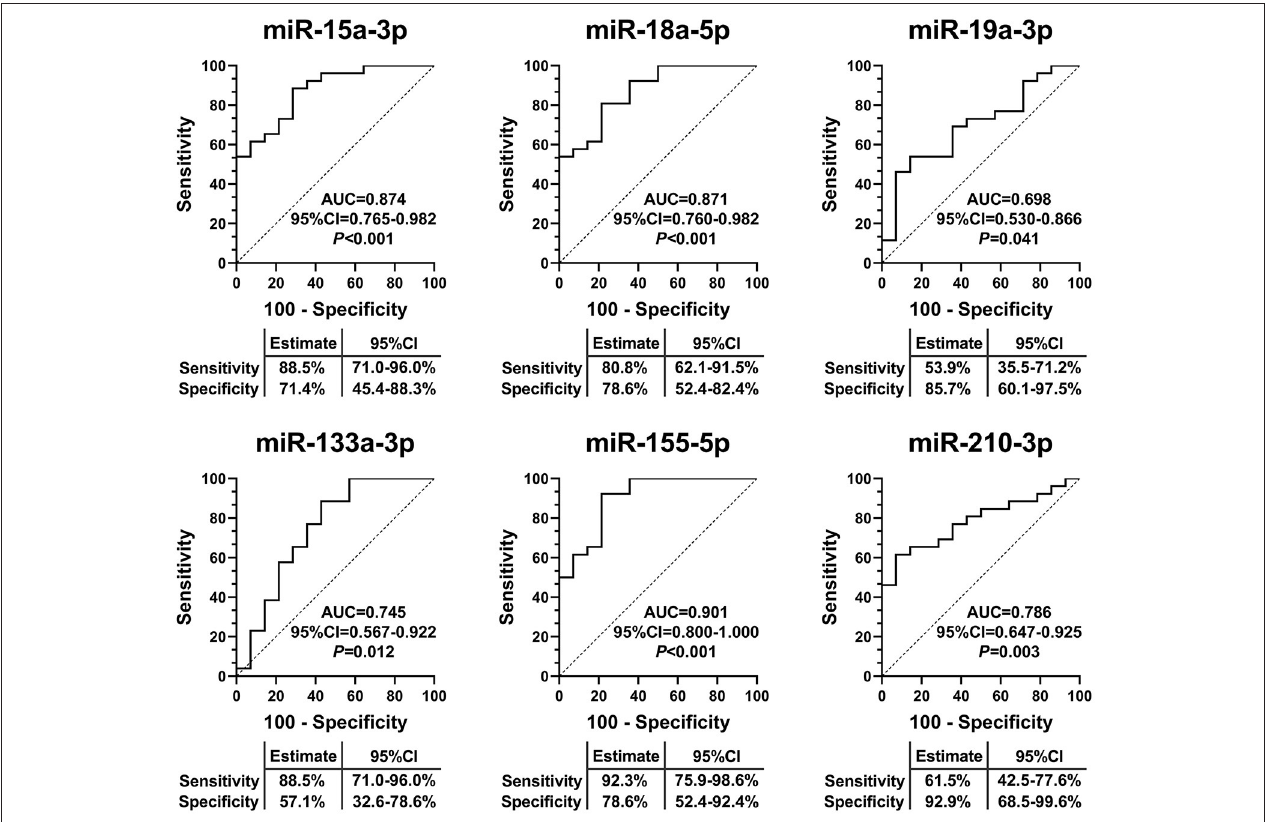
FIGURE 4 | EV-carried miRNAs as useful biomarkers to distinguish IHD-DM from healthy controls. ROC curve analyses displayed EV-carried miR-15a-3p, miR-18a-5p, miR-19a-3p, miR-133a-3p, miR-155-5p, and miR-210-3p as useful biomarkers to discriminate IHD-DM from healthy controls. P < 0.05 was considered statistically significant. AUC: area under the